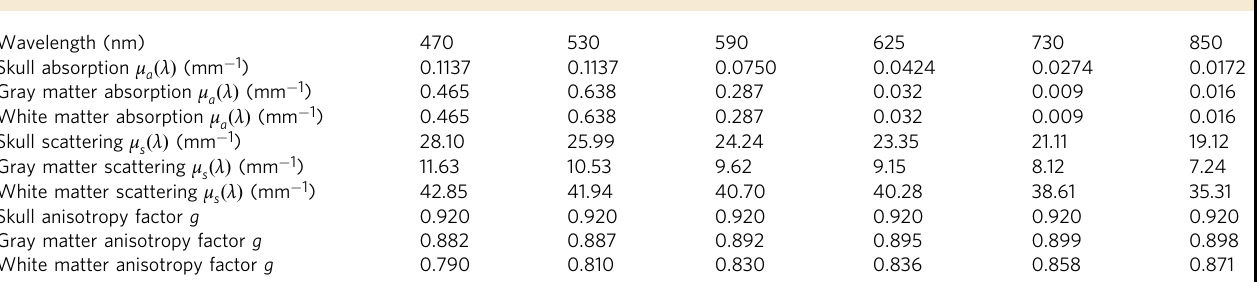
Table 1. Optical and physical properties of the skull and the brain. Wavelength